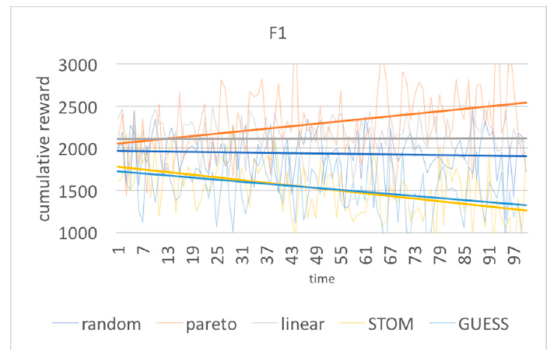
Figure 3. Cumulative reward over time for f (1) .